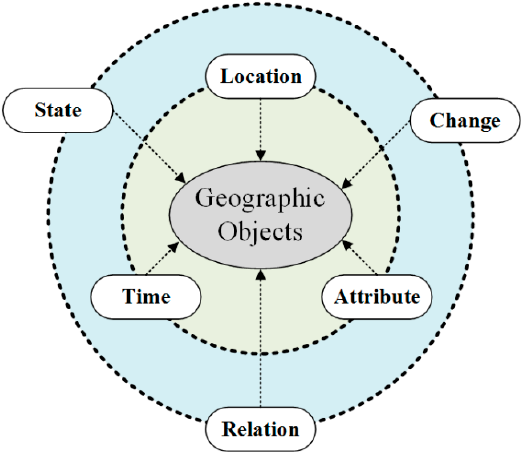
Figure 2. The six basic elements to represent a geographic object.